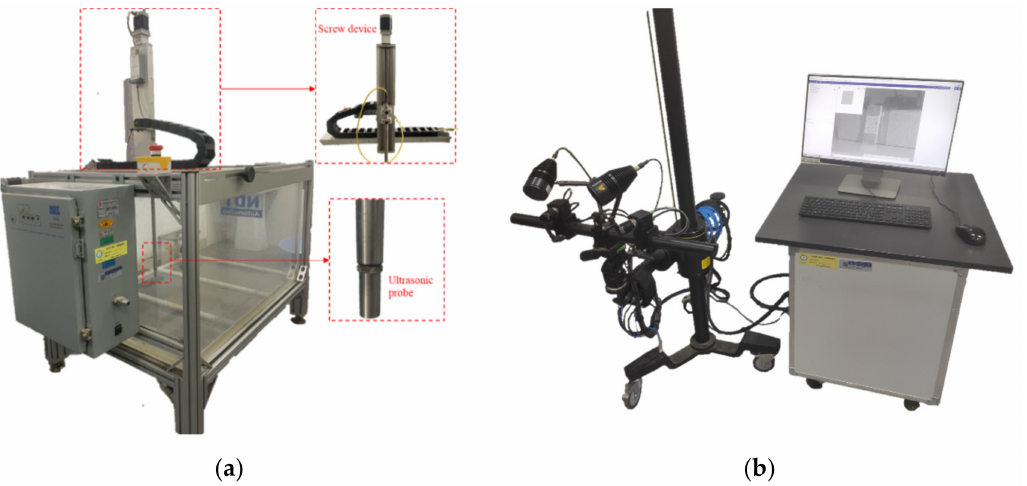
Figure 4. Equipment: ( a ) UltraPAC ultrasonic C-scan system; ( b ) DIC measurement system.